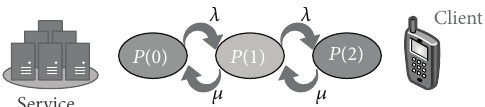
Figure 1: Markov chain with a buffer length of two requests.